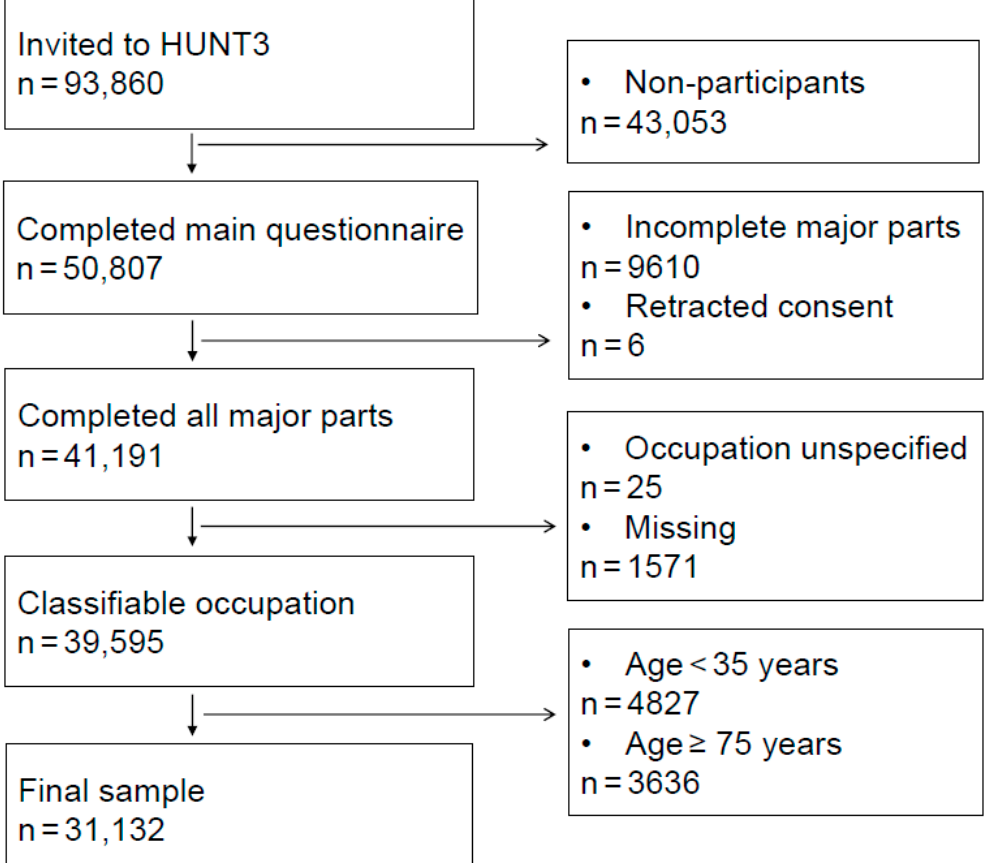
Figure 1. Flowchart for sample selection.